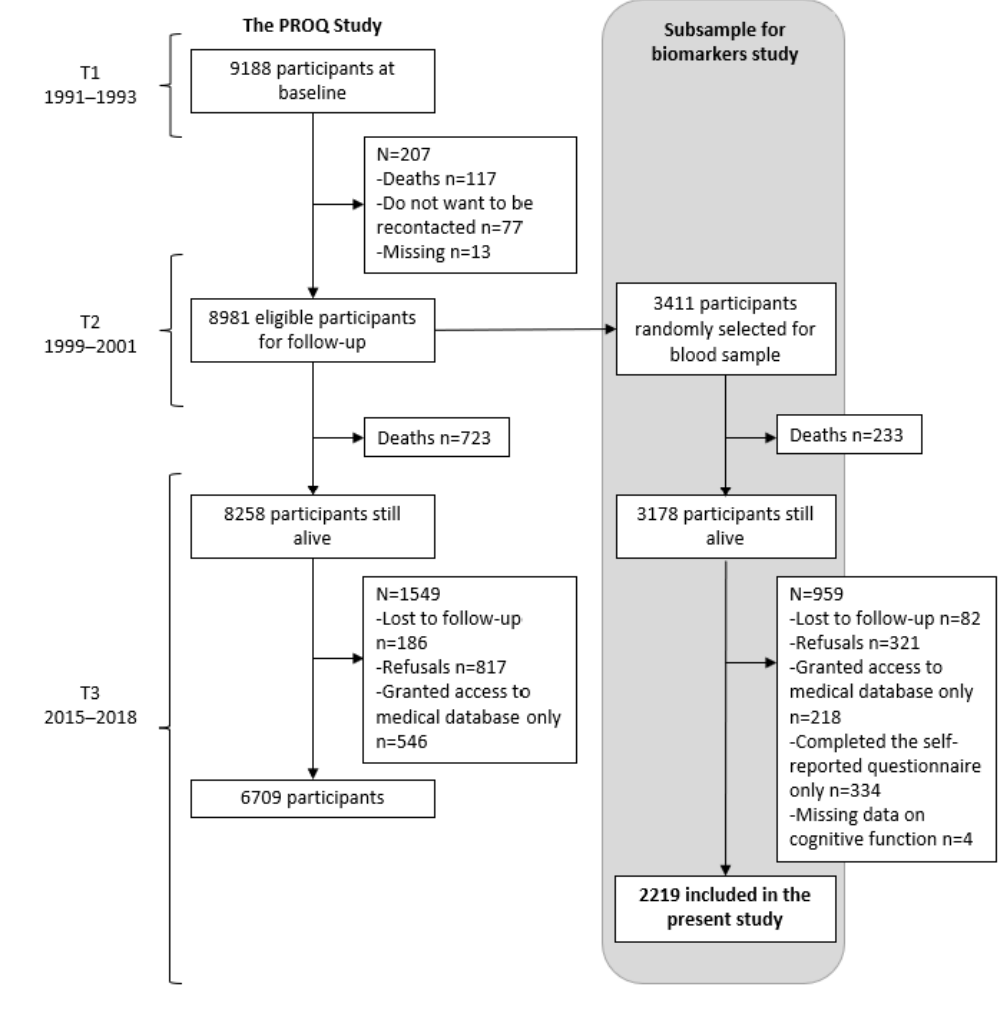
Figure 1. Flow chart of the study population.